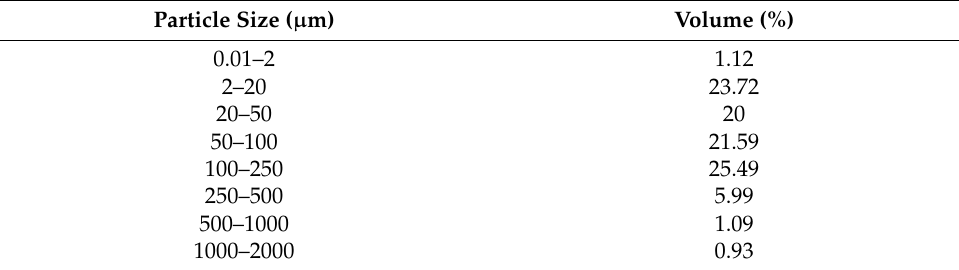
Table 5. Division of the FA into fractions.